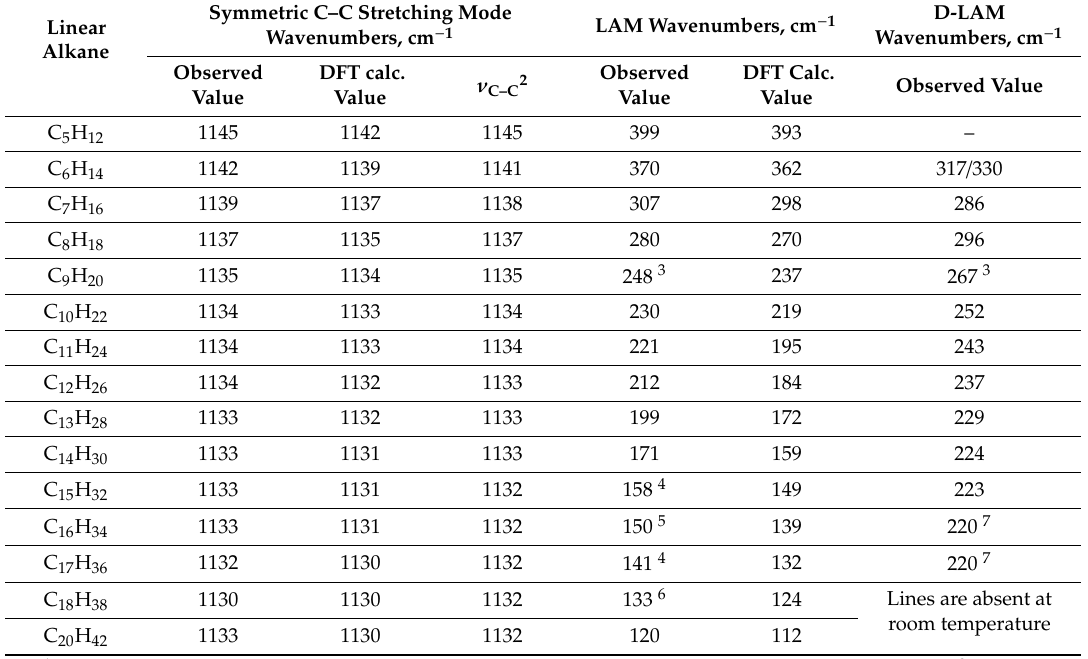
Table A1. Wavenumbers of the symmetric C–C stretching mode, LAM, and D-LAM bands for linear alkanes 1 . Symmetric C–C Stretching Mode Linear Wavenumbers, cm − Alkane